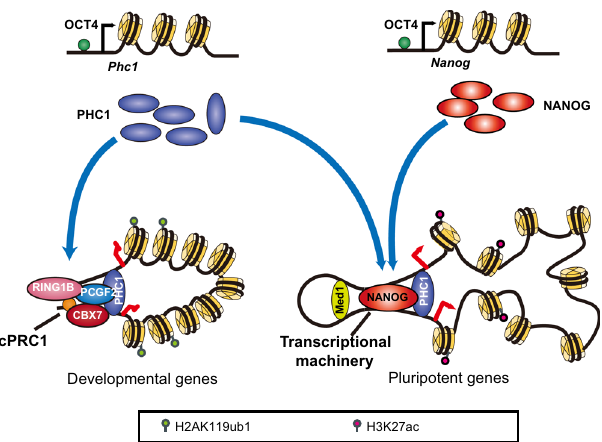
Fig. 6 Proposed model. Phc1 , similar to Nanog , is transcriptionally activated by Oct4. While PHC1 exerts PRC1-dependent repression of development genes by associating with other cPRC1 subunits such as RING1B, CBX7, and PCGF2, it also interacts with Nanog to regulate chromatin landscape of the Nanog locus and activate pluripotent